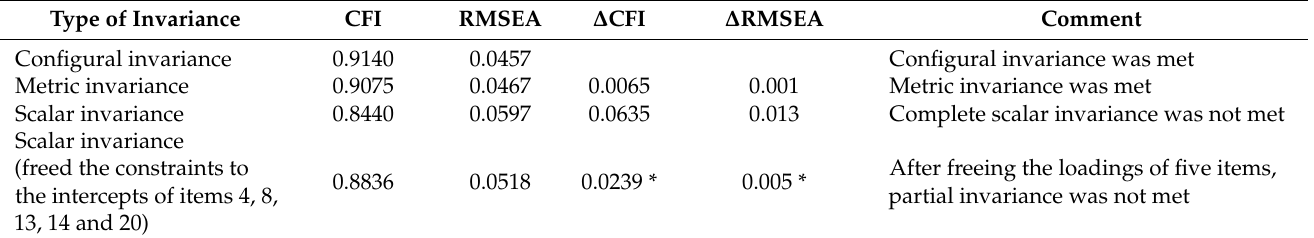
Table 3. Summary of the results of the Multigroup CFA performed to assess the measurement invariance of the Maslach Burnout inventory across study waves (n =